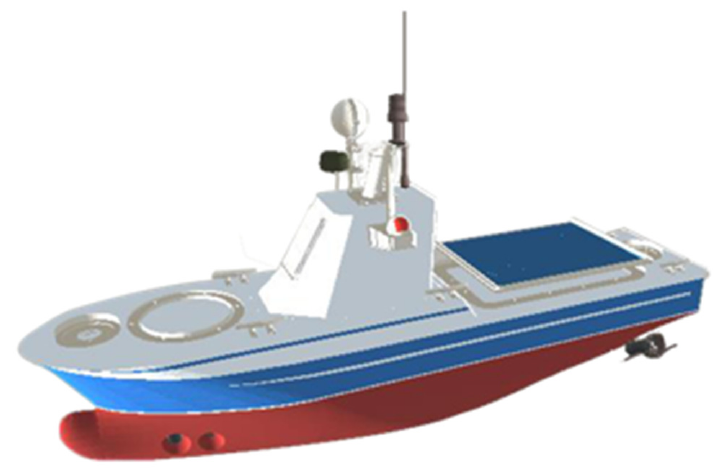
Figure 10. USV Figure 10. USV model.